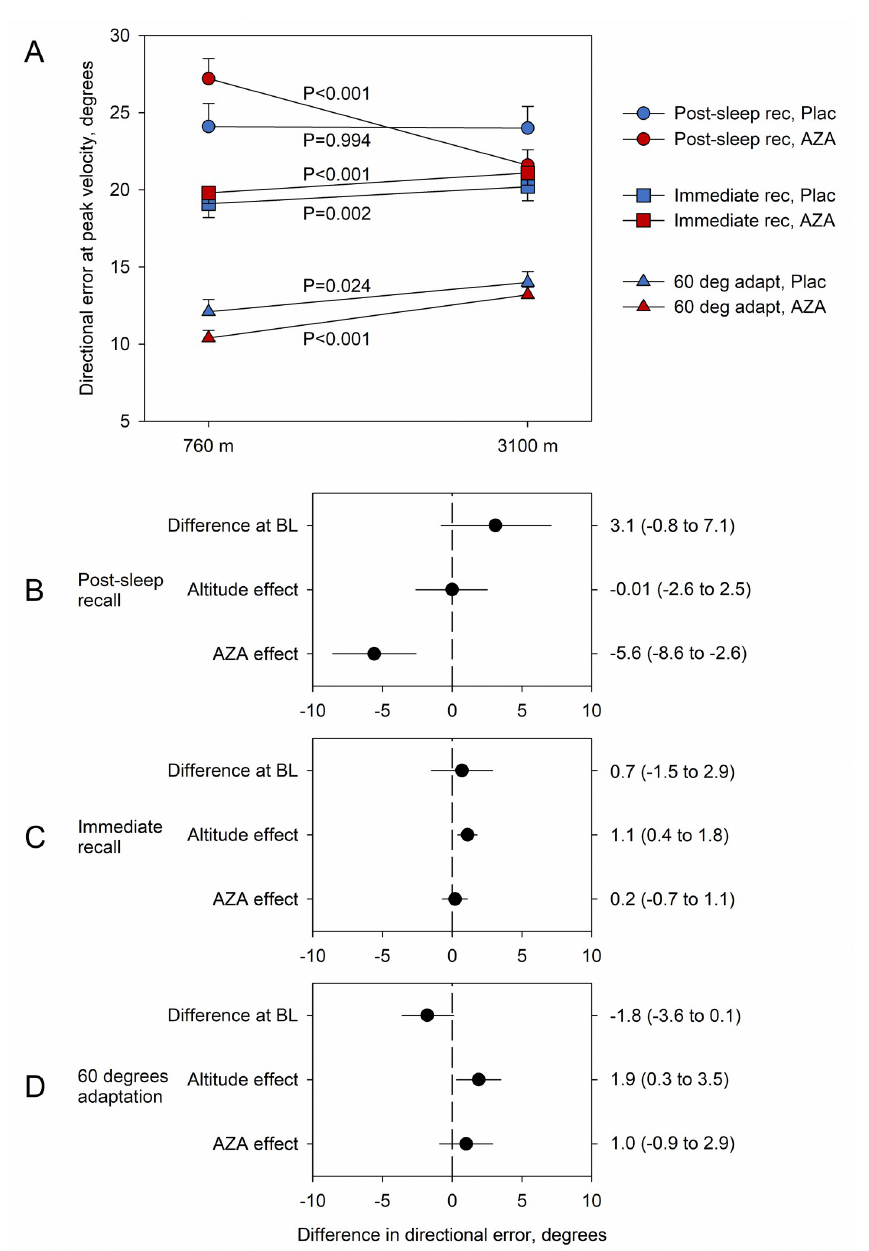
Fig 3. Effect of altitude and medication on directional error. (A) Average predicted margins of directional error at peak velocity during post-sleep recall (Post-sleep rec, circles), immediate recall (Immediate rec, squares) and 60˚ adaptation (60 deg adapt, triangles) in the groups using Placebo (Plac) and acetazolamide (AZA) at 760 m baseline and at 3100 m altitude. (B) Average marginal effects on directional error at peak velocity (with 95% confidence intervals) of groups at baseline (Difference at BL, without drug); (C) effects of altitude (Altitude effect); and (D) effects of acetazolamide at 3100 m (AZA